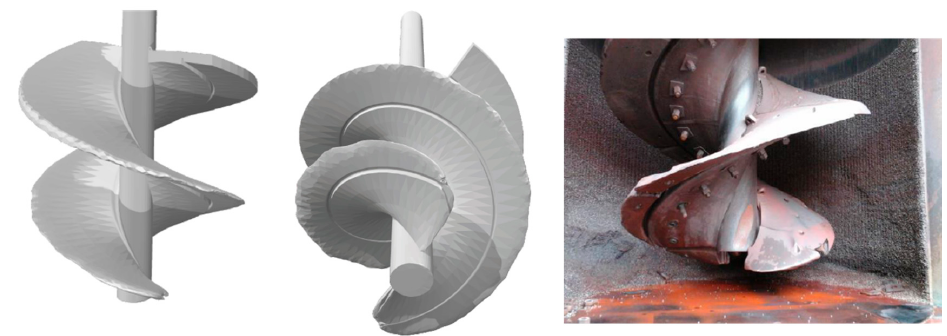
Figure 20. Comparison between 3D worn screw after DEM simulation and industrial worn liner.